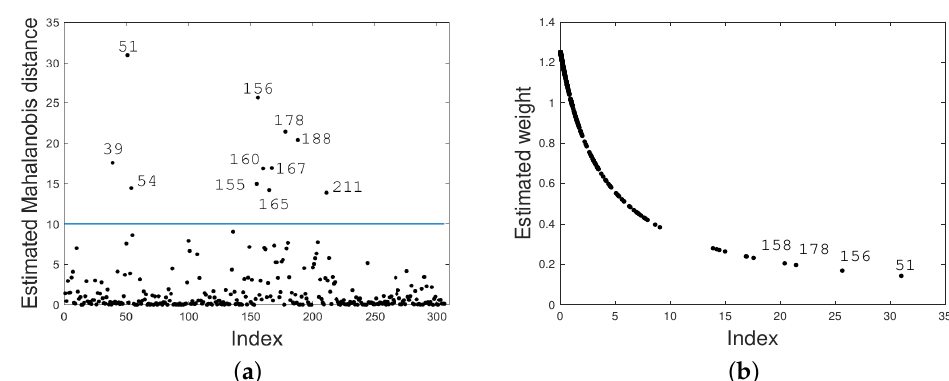
Figure 14. Index plots of the Mahalanobis distance ˆ δ i ( a ) and the estimated weights ˆ δ i ( b ) for Student-t PVCM (Lima